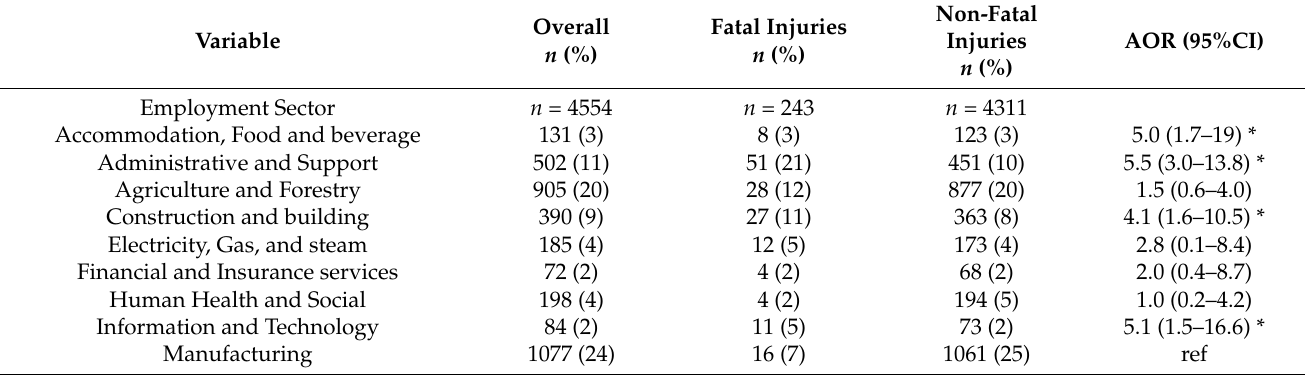
Table 4. Work-related injuries reported to WCF classified by employment sector and job